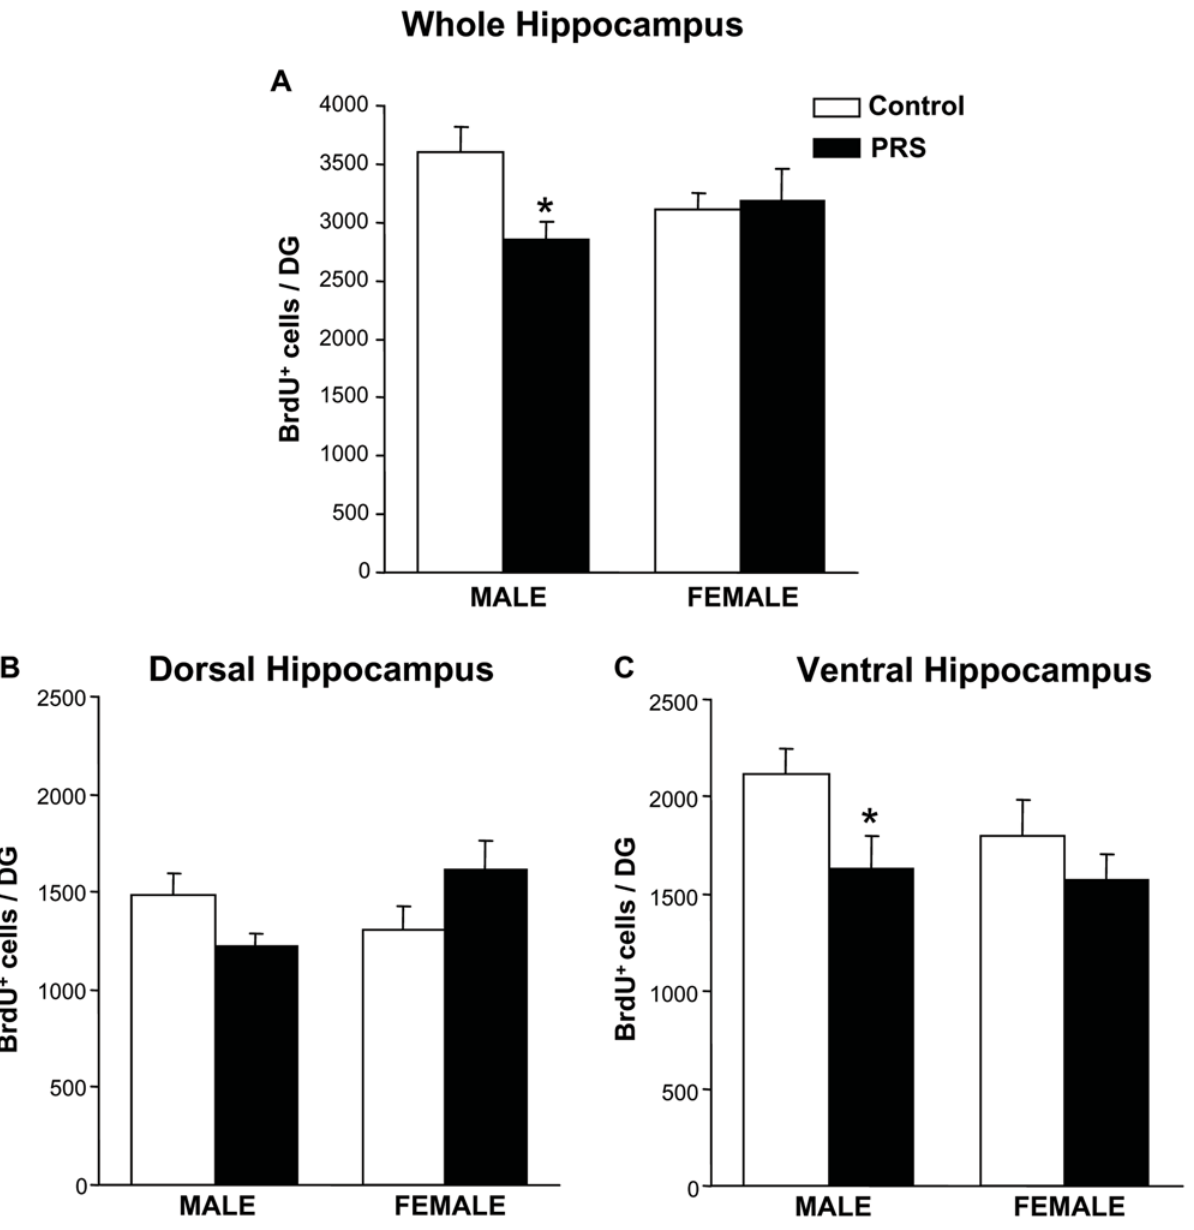
Figure 2. Gender effect of PRS on the survival of newly-formed cells in the hippocampal dentate gyrus. Data obtained in the whole hippocampus and in the dorsal and ventral hippocampus are shown in (A) , (B), and (C) , respectively. In the whole hippocampus the outcome of PRS was gender-dependent (ANOVA group 6 sex interaction: F (1,16) =4.53, p , 0.05;). Values are means 6 S.E.M. of 5 measurements. * p , 0.05 for PRS vs control males, ANOVA + Newman-Keul’s post-hoc test